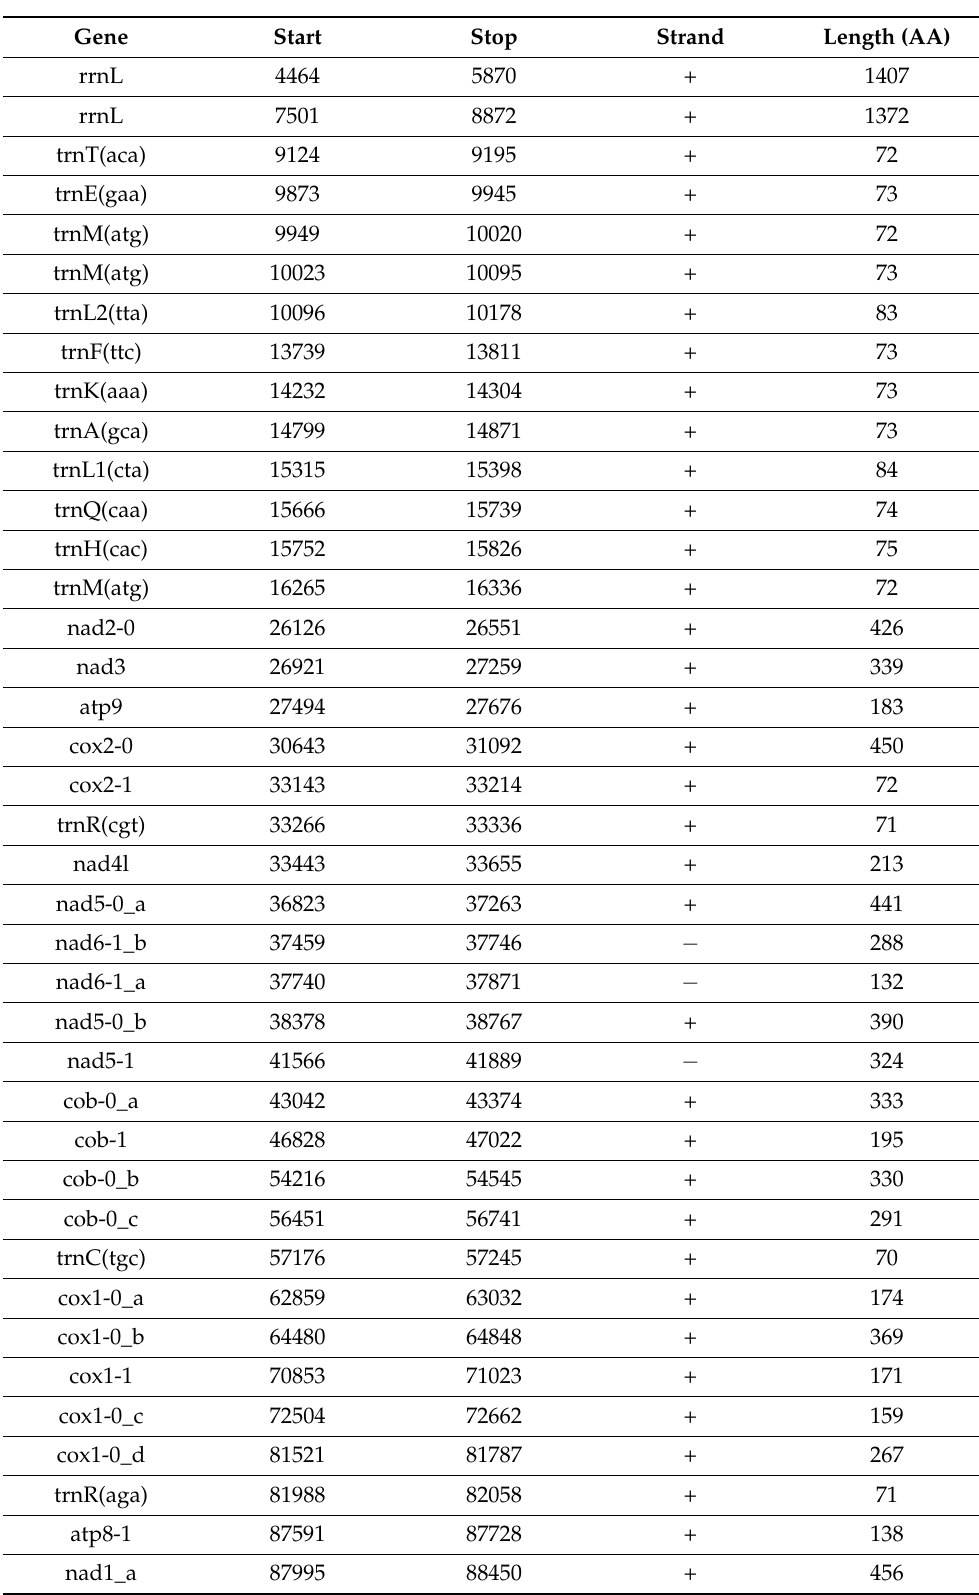
Table 3. Summary of genetic components of O. lanpingensis